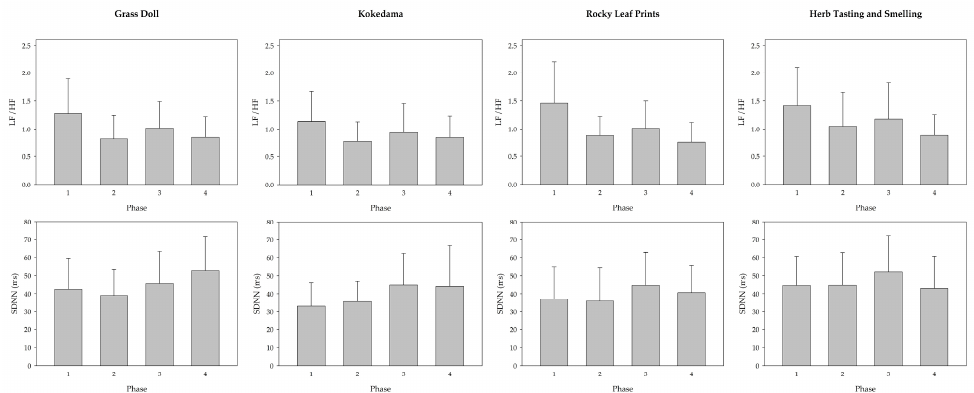
Figure 2. Effect of various types of horticultural activities on the changes in the ratio of the low frequency over high frequency (LF / HF) and the standard deviation of the NN intervals (SDNN). N = 27, mean ± standard deviation.